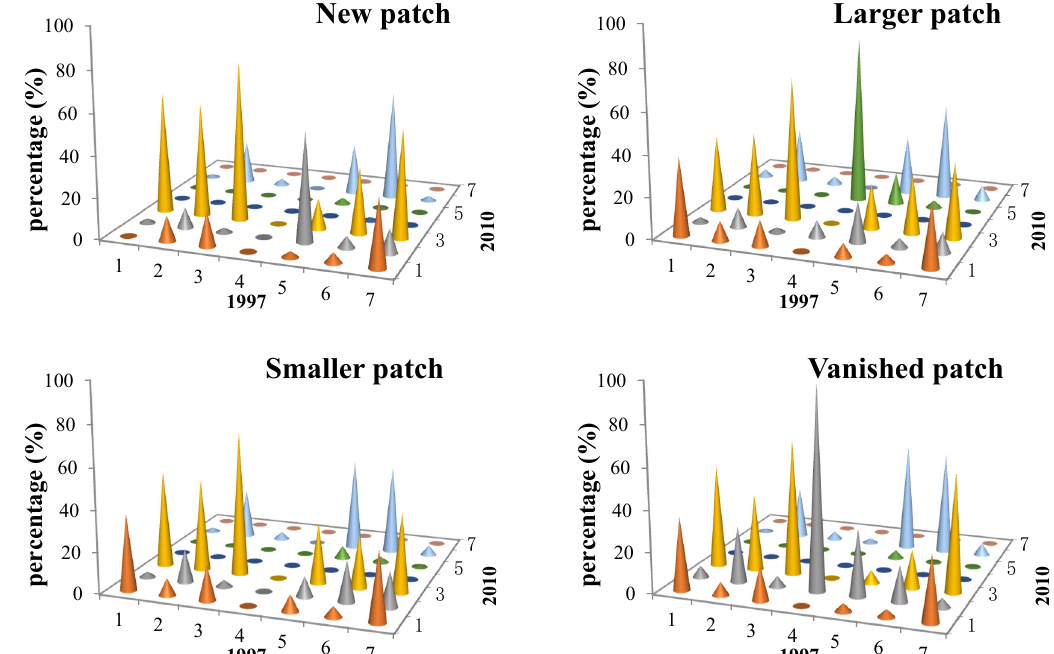
Figure 6. Transition proportions of land ecosystem in the buffer zones of various rural settlements evolution types. 1: forest, 2: grassland, 3: farmland, 4: wetland, 5: water areas, 6: alkali land, 7: unused land, 8: construction land.